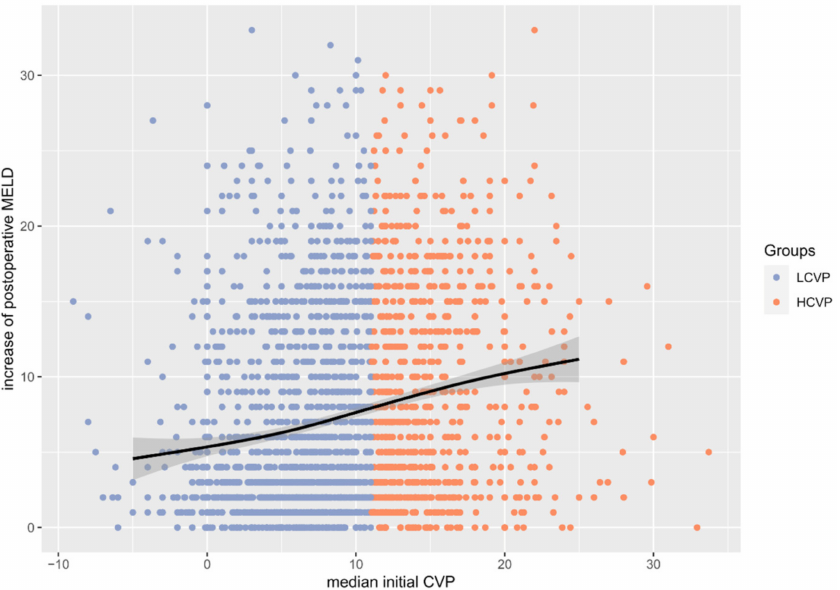
Figure 3. Rise of postoperative MELD score in relation to median initial CVP. MELD: Model of End-Stage Liver Disease Score.